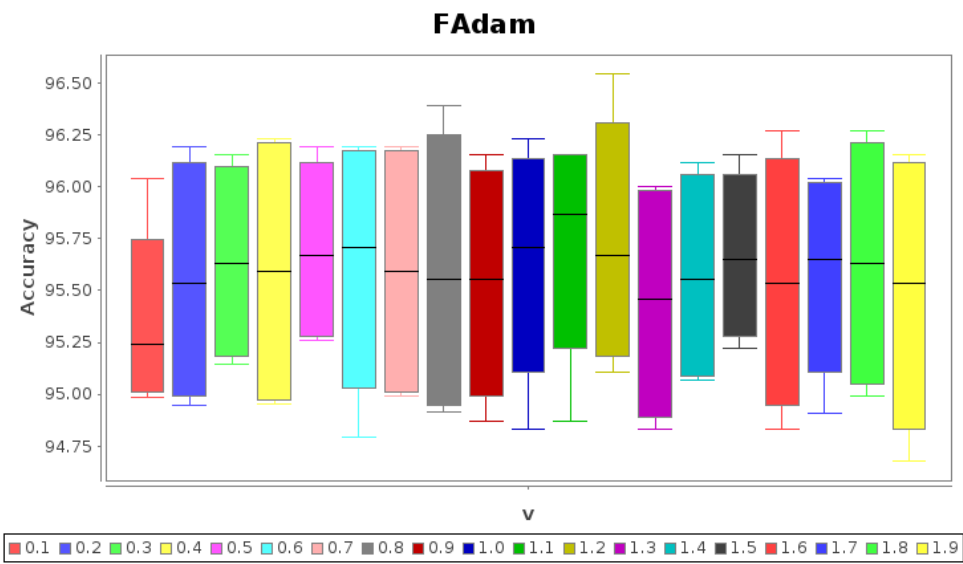
Figure 16. Experiment 3.2: FAdam cross-folding accuracies, K = 4 folds, ν ∈ [ 0.1,1.9 ] .